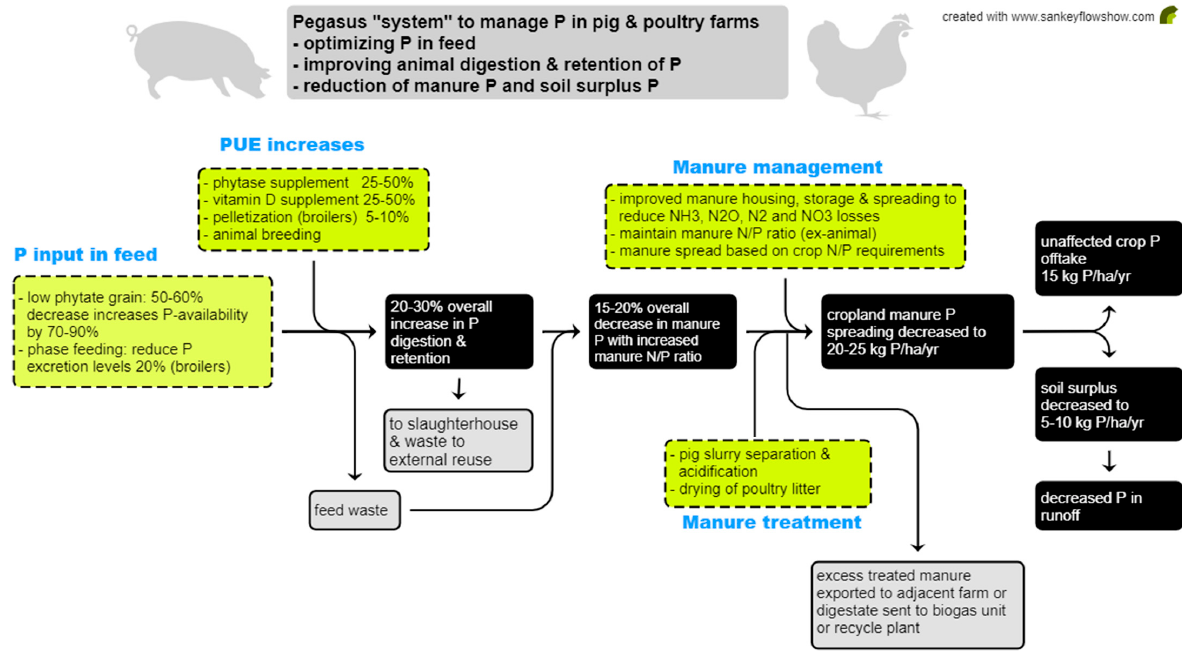
Figure 12. A system “mind map” for pig and poultry farms: optimizing feed P, improving animal digestion and retention of P, reducing manure P and soil surplus P, and finally decreasing runoff P. The percentages given in the yellow rectangles reflect results from single factor experiments. The percentages given in the black squares are the overall combined estimates of the various manipulations. The diagram is intended to be indicative of that which is possible to achieve. Sources [64,94,96].